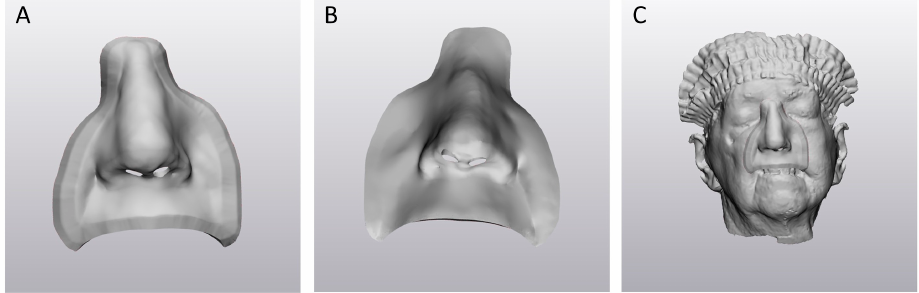
Figure 4. Final virtual design of the prosthesis. ( A ) Anterior view; ( B ) posterior view; ( C ) final prosthesis positioned on the patient’s face scan.